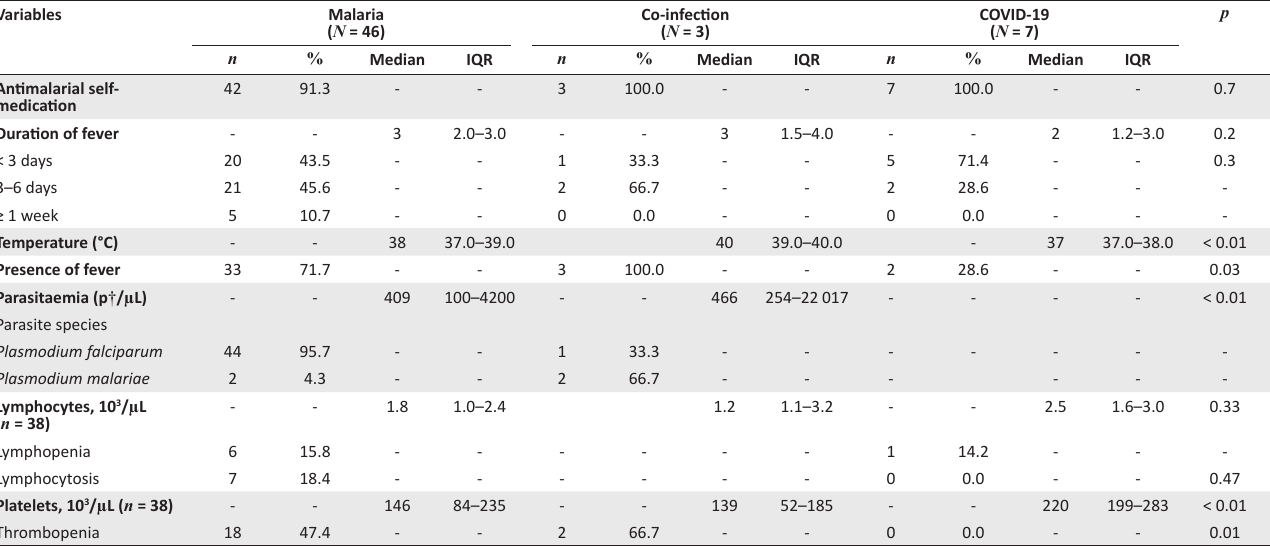
TABLE 3: Characteristics of single and malaria and COVID-19 co-infection.